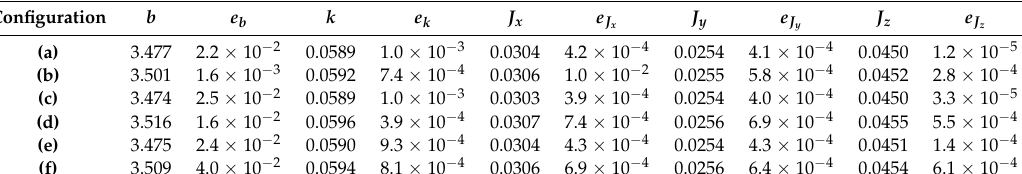
Table 5. Average value estimates and mean errors.